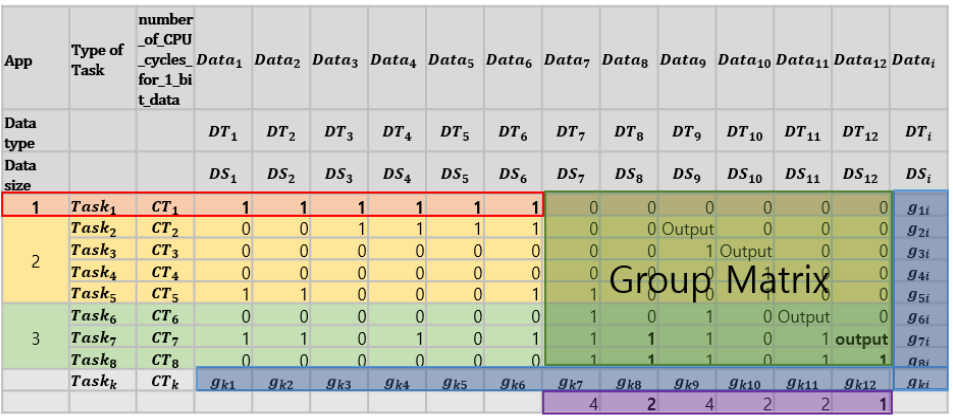
Figure 3. List expression task based on data-centric offloading.